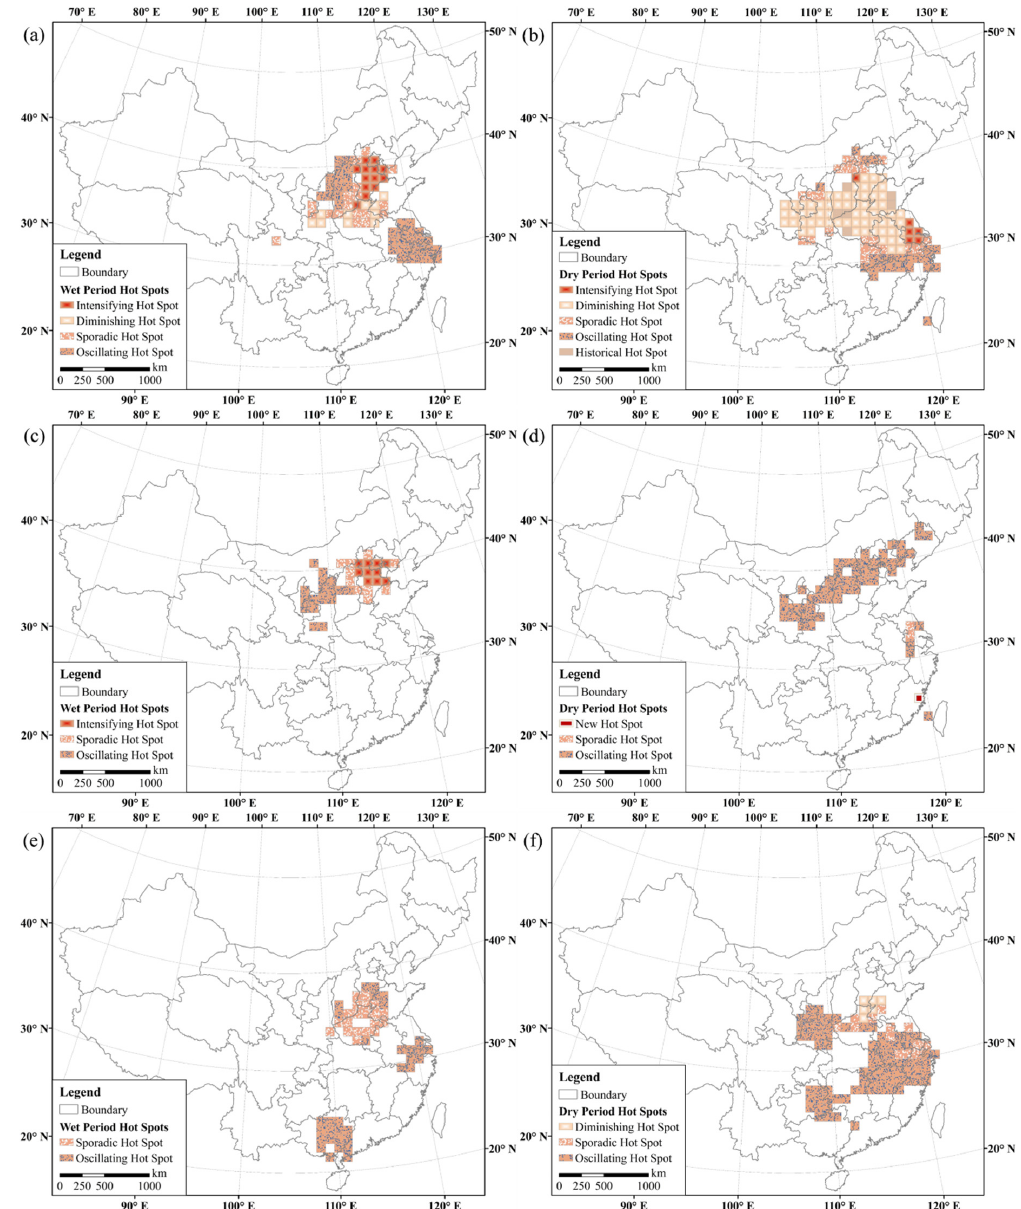
Figure 4. EHSA patterns of all wet and dry stages for three kinds of war. (a,b) All war, (c,d) agri- nomadic conflict, and (e,f)